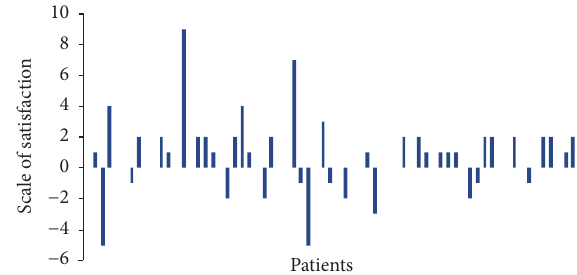
Figure 5: Patients level of satisfaction. 29 patients showed a higher satisfaction after Wand anesthesia, while 12 had a higher satisfaction after traditional